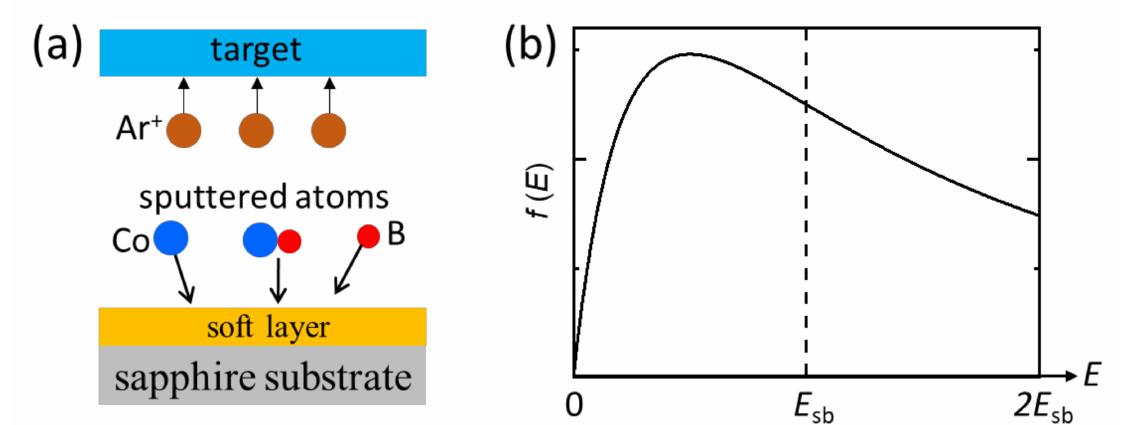
Figure 1. ( a ) Schematics for the sputtering process. An Ar + ion bombards the CoB alloy target. Target elements are ejected from the target surface and deposited on the substrate. ( b ) The number distribution ( f ) of the sputtered elements from the target surface is a function of the kinetic energy ( E ). The maximum f occurs at E with around half the surface binding energy ( E sb ) of the target